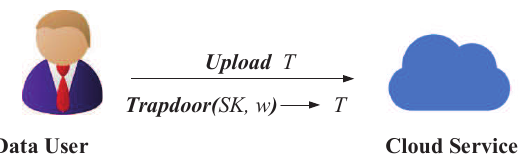
Figure 5. Trapdoor